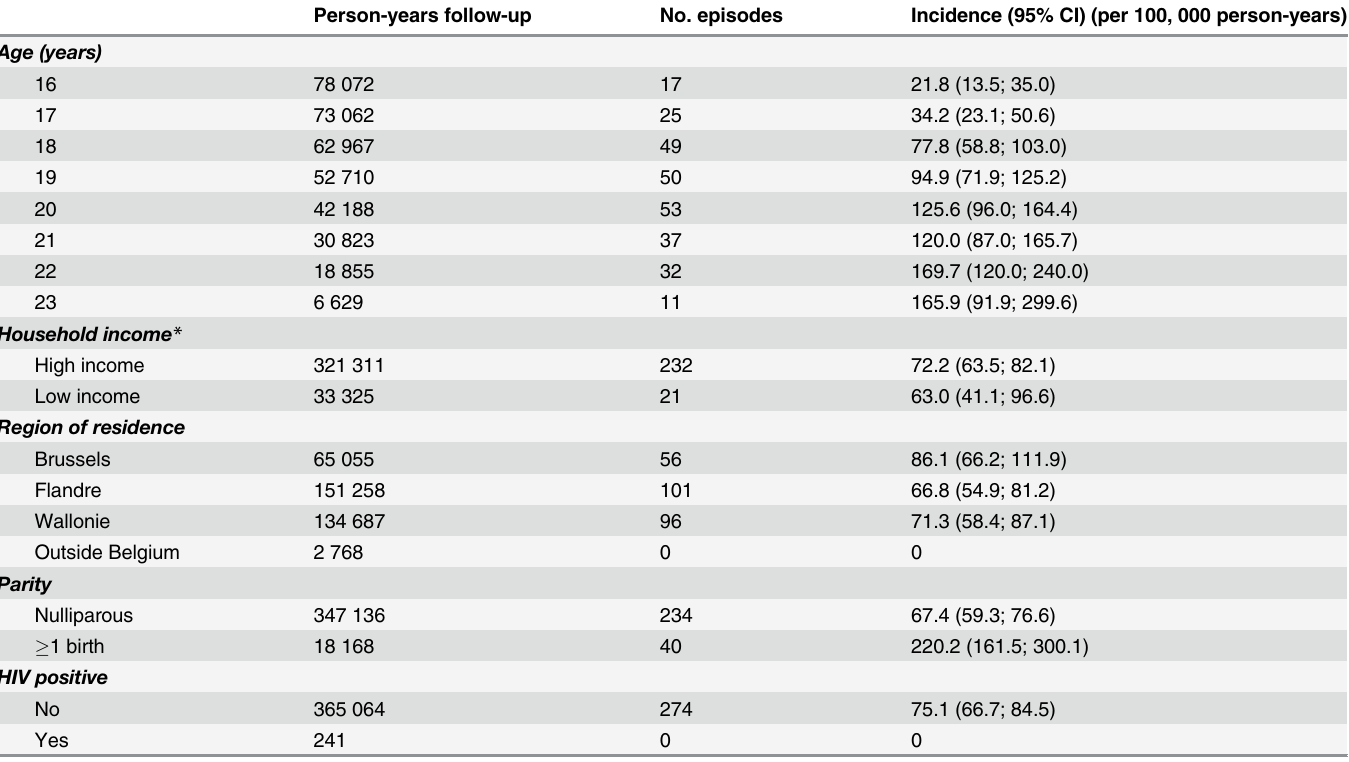
Table 3. Estimated genital warts incidence rates per 100 000 person-years, stratified by potential risk factors for the population eligible for vaccine effectiveness